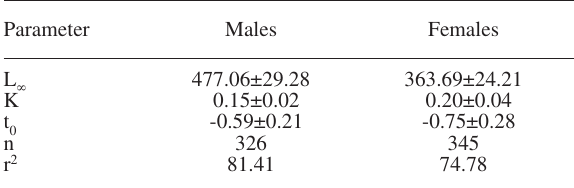
Table 2. – Growth parameters (± se) derived from the von Ber- talanffy growth function for H. didactylus sampled in the Bay of Cádiz between March 1999 and March